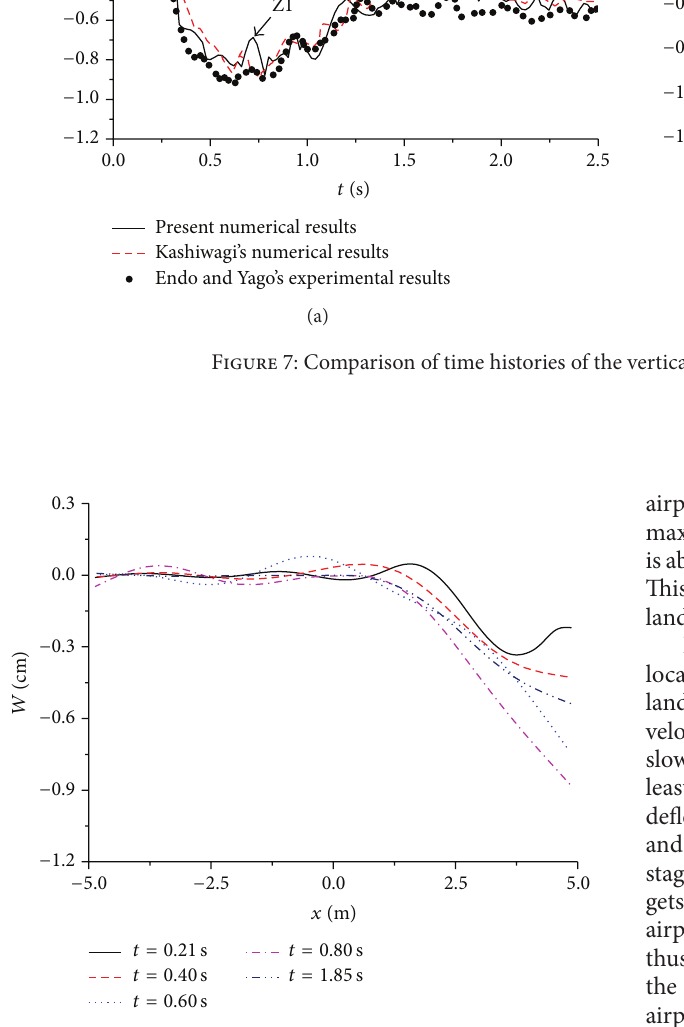
the VLFS; after three cycles of the wave period, the airplane touches down the runway in the following incident wave direction. The wavelength is 650 m (0.13 times of the runway length), period 23.6 s, height 2.0 m, and incident angle is 0